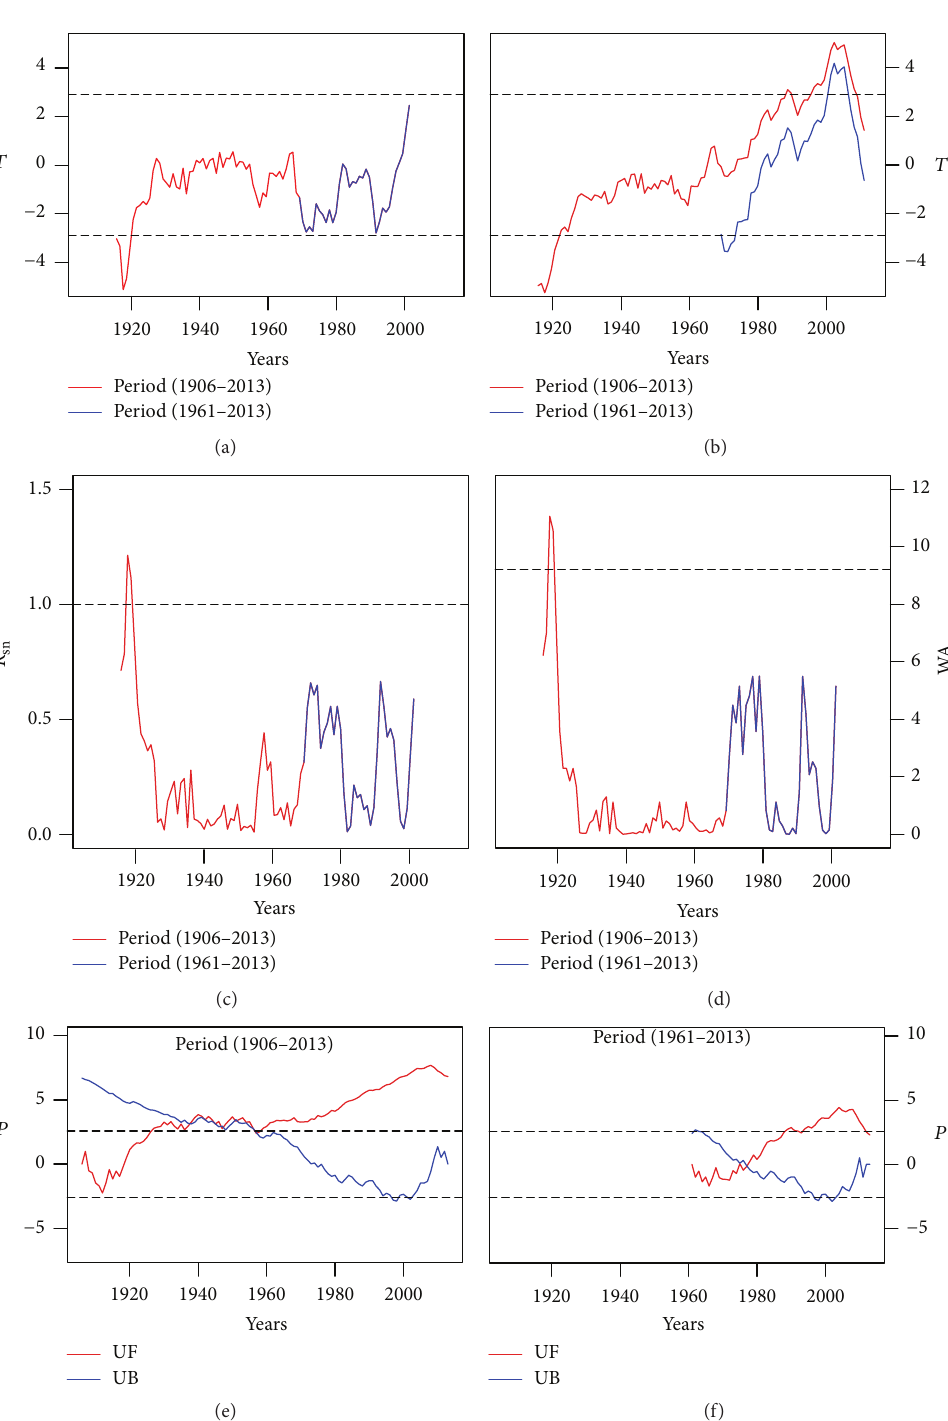
Figure 9: Effects of different study periods on the five detection methods: (a) MTT, (b) CRA, (c) YAMA, (d) LP, (e) MK for the period 1906–2013, and (f) MK for the period